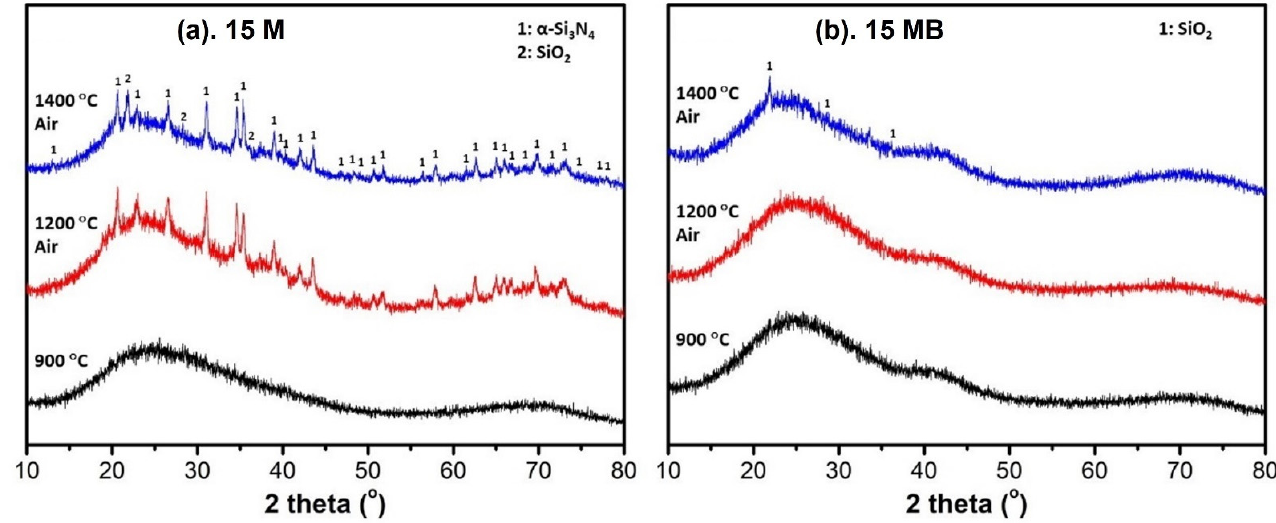
Figure 11. XRD spectra of the oxidation products of the two precursors ( a ) 15 M and ( b ) 15 MB at different temperatures.